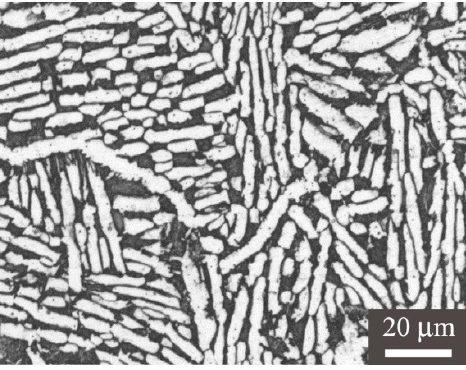
Figure 1. Microstructure of Ti-6Al-2Sn-2Zr-3Mo-X alloy.